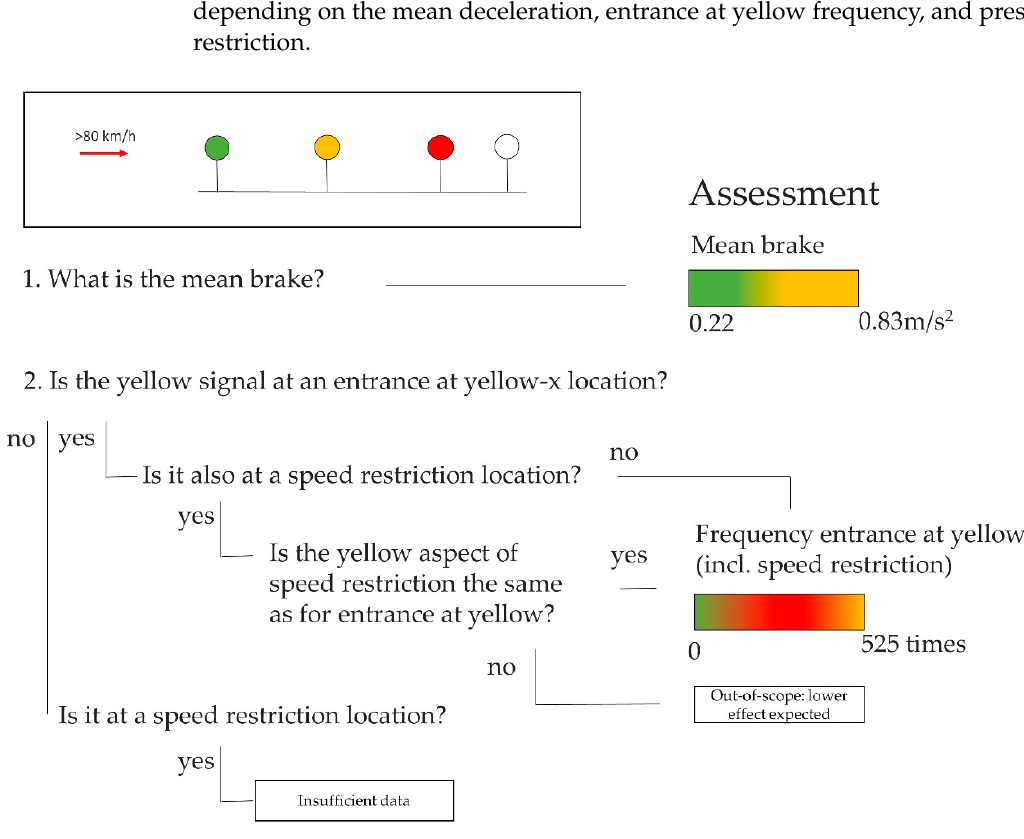
Figure 18. A simplified illustration that different factors need to be considered to predict differences in behavior.